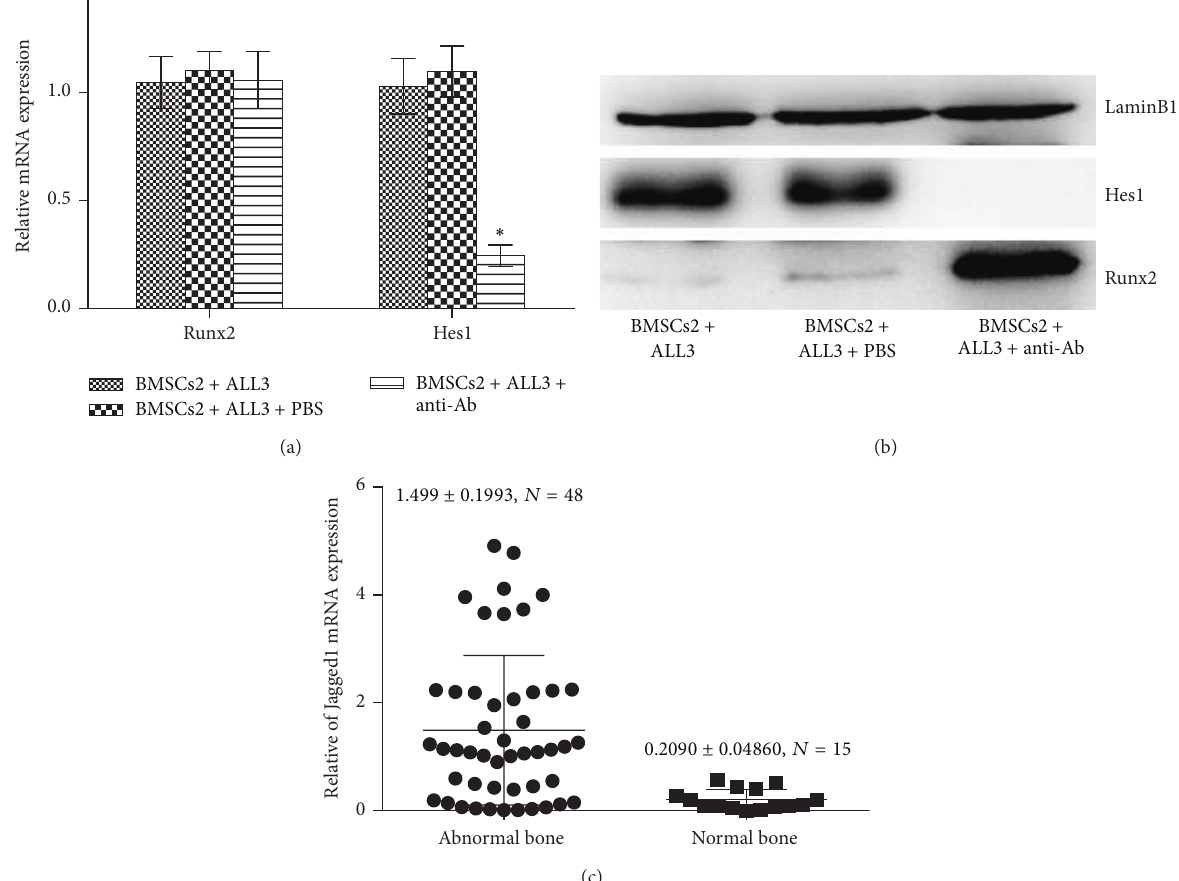
that the effect of ALL cells on BMSCs is